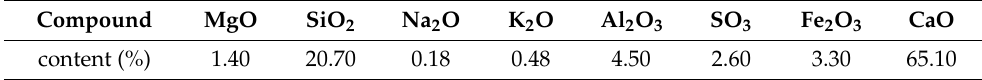
Table 2. Main mineral composition of cement.